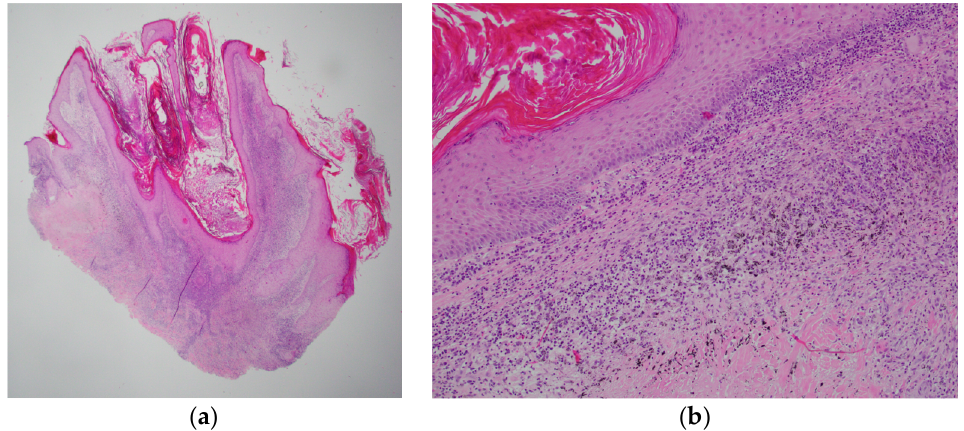
Figure 2. Skin biopsy at 12.5× magnification ( a ) showing orthokeratosis, hyperplastic squamous epithelium, papillomatous change and lichenoid inflammation at superficial dermis. At 100× magnification ( b ), tattoo pigment and lichenoid reaction is shown in the superficial dermis.